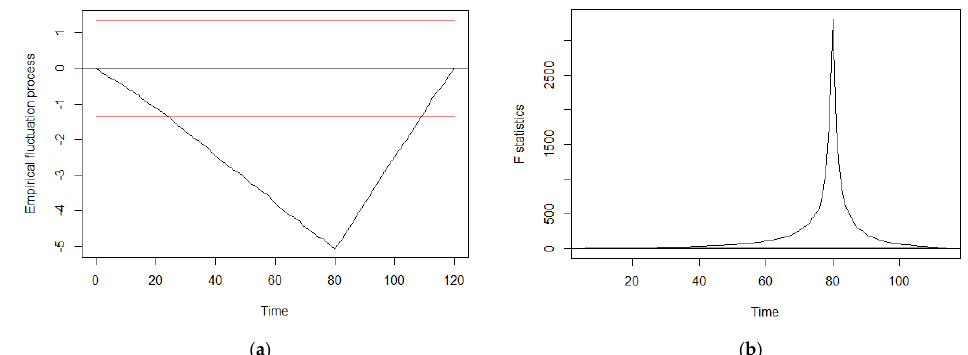
Figure 6: Statistical test results (minimal base model). (a) Empirical Fluctuation (b) F-Statistics Figure 6. Statistical test results (minimal base model). ( a ) Empirical Fluctuation ( b ) F-Statistics.